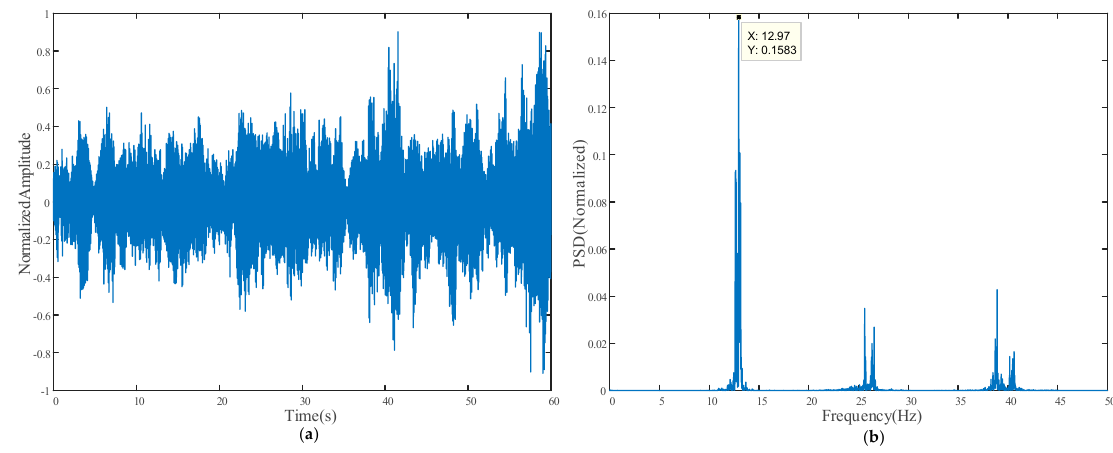
Figure 15. Vibrometer field experimental result: ( a ) Time history of normalized acceleration signal; ( b ) Normalized power spectrum density.